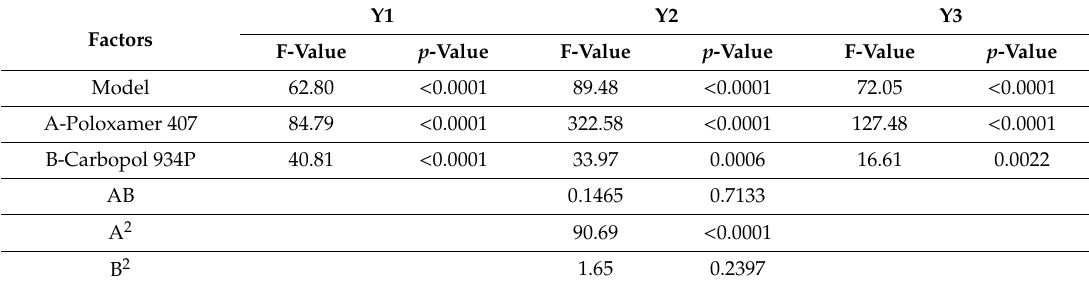
Table 7. Independent factors for the estimated effects, F-ratio, and associated p -values for NTS in situ